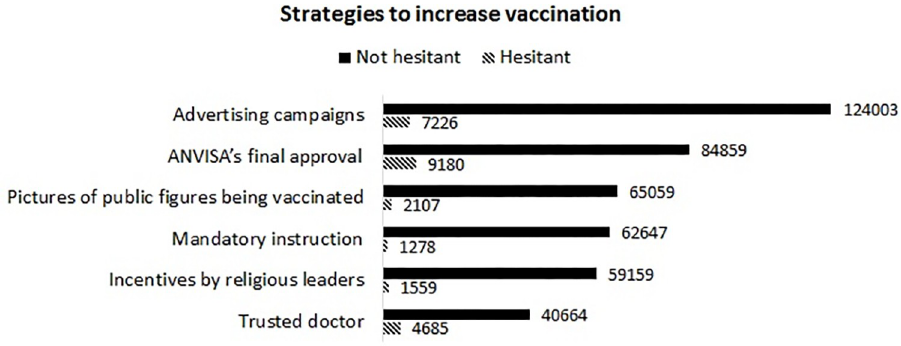
Fig 4. Strategies indicated to increase the percentage of vaccine adherence to prevent COVID-19 according to the intention to vaccinate.